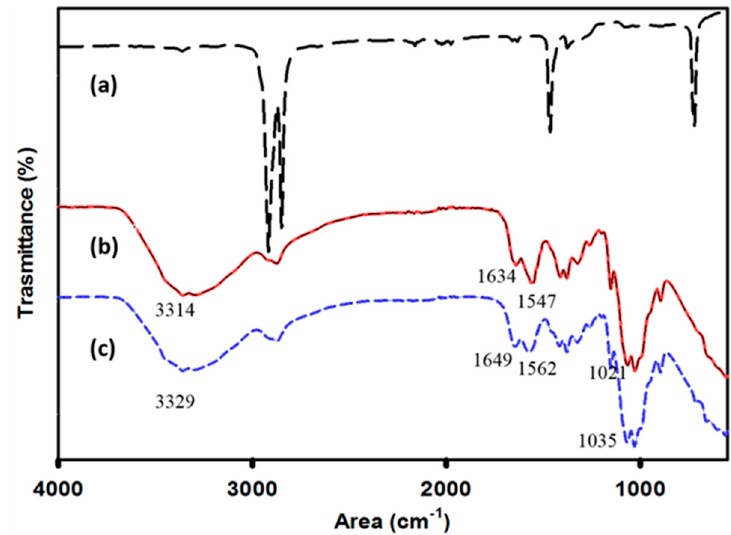
Figure 2. Fourier transform infrared FTIR spectra of low density polyethylene films (LDPE) films coated with chitosan and chitosan-ZnO nanocomposite compared to uncoated LDPE: ( a ) uncoated LDPE; ( b ) LDPE coated with chitosan-ZnO nanocomposite; ( c ) LDPE coated with chitosan.